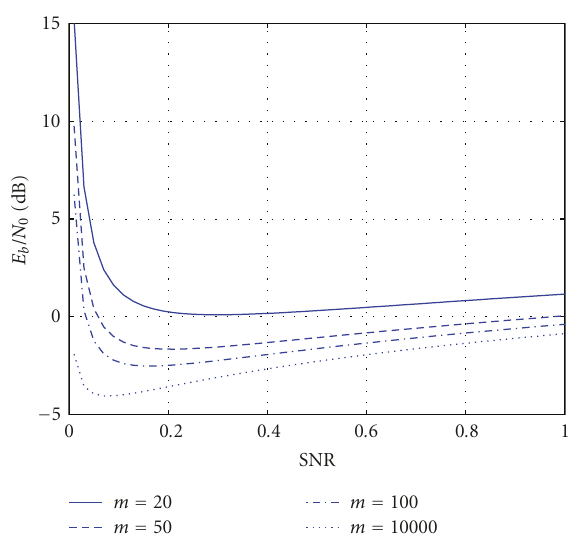
Figure 15: Nonoverlapped AF E b , U /N 0 versus